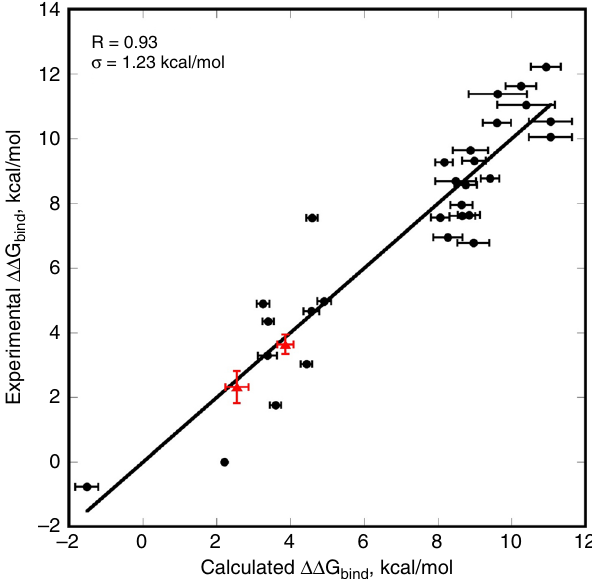
Fig. 3 Correlation between the NGS-based vs. experimental ΔΔ G bind . Experimental ΔΔ G bind values were obtained for puri fi ed protein variants of BPTI interacting with BT. Black circles show the data taken from the literature. Red triangles show experimental data obtained in this study. Error bars on the X-axis show standard deviations calculated from the bootstrapping of the NGS data. Analysis of the correlation excluding our two data points gives R -value of 0.93; σ = 1.23 kcal mol − 1 and p -value of 10 − 5 in the two-tailed test. Source data are provided as a Source Data fi le.